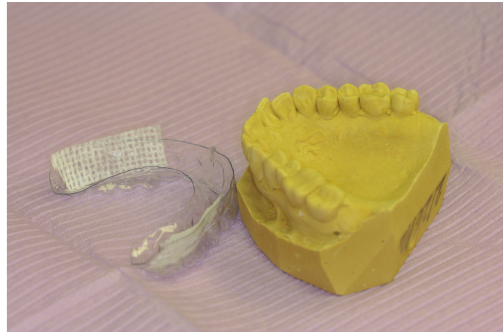
Figure 1: Dental appliances selectively lined with Surgicel according to areas with active